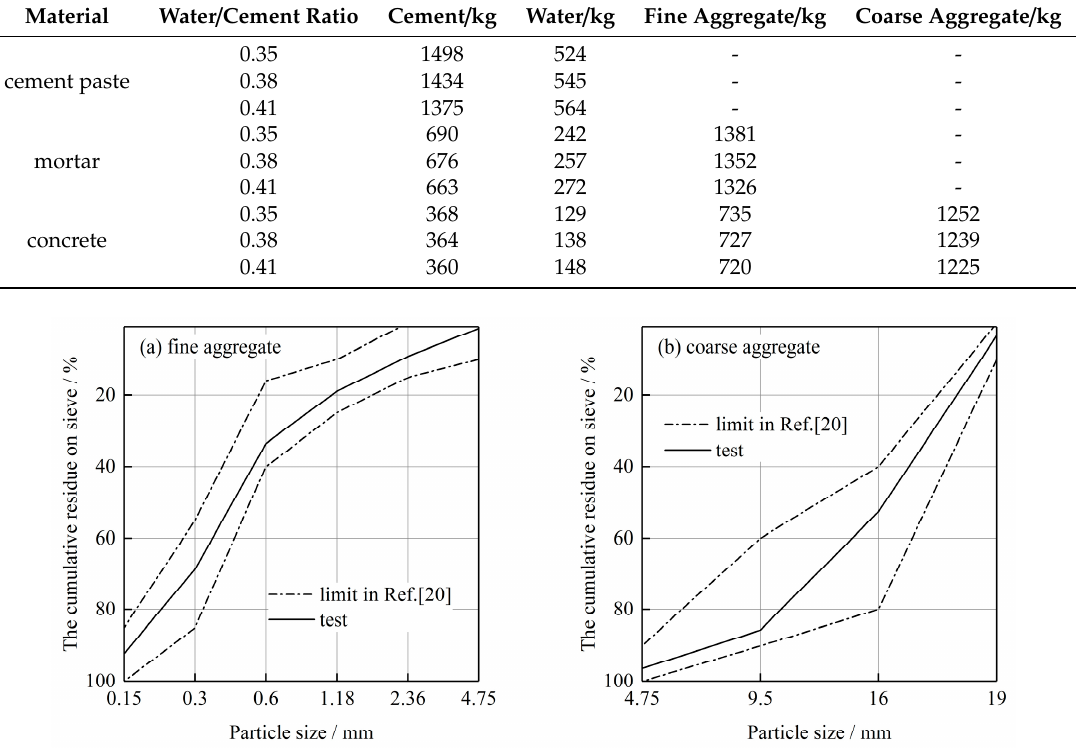
Figure 1. Grading curves of ( a ) fine aggregate and ( b ) coarse aggregate.